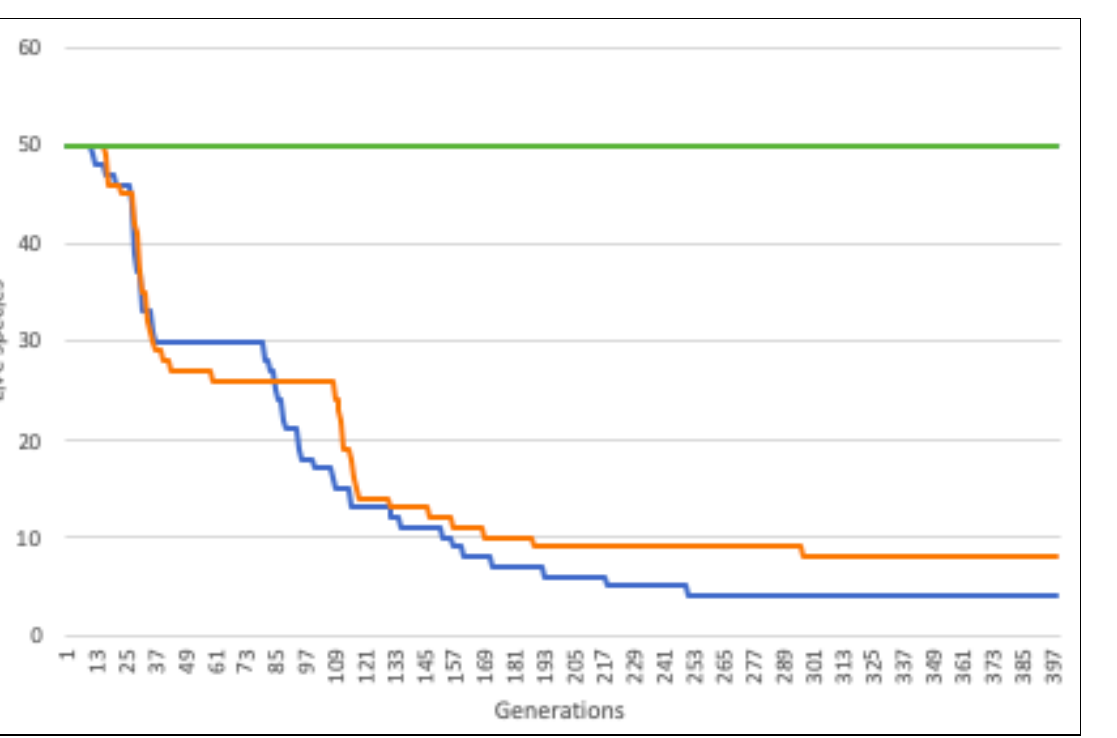
Figure 6. The paradox of the plankton at large-scale. Data obtained from 2Planck1.json in Supplementary Material. The X -axis represents the 400 generations and the Y -axis the species that coexist despite all of the 50 species having different fitness. The fitness grows from S1 in which DirectOffspring is 10, to S50 in which DirectOffspring is 59. When the distribution is uniform globally (blue and orange curves with strategies of 1r and 20r , respectively) the species with lower fitness become progressively extinct; whereas when the distribution is aggregated, with more variance (the green line represents the distributions of 40r , 60r , 80r and 100r ) all the species remain in equilibrium; none is excluded even though species S1 had 10 descendants on average and S50 had 59.